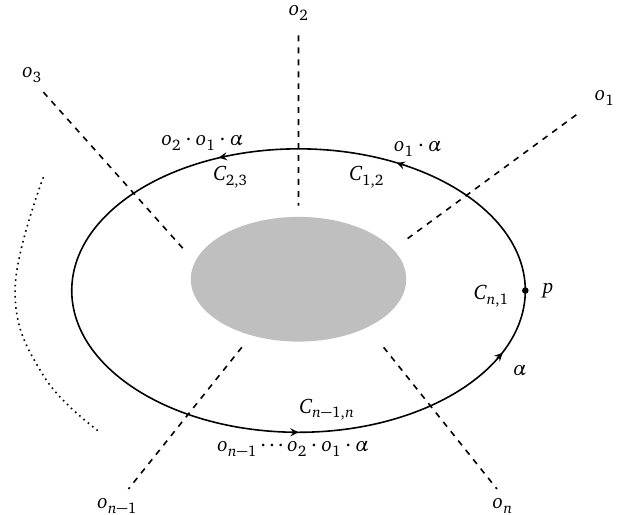
Figure 24: A loop C on Σ point p , the loop intersects various outer-automorphism twist lines o sub-segment of C between the locations of intersections with o C . Once the element α ∈ S i , i + 1 carried by the sub-segment C